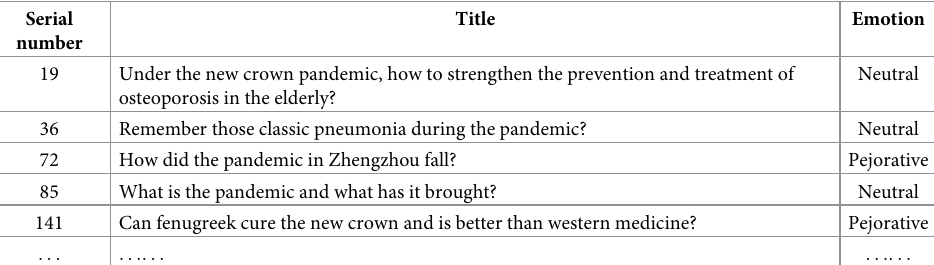
Table 4. Cases of user participation in asking questions in the "Lilac Forum" during the